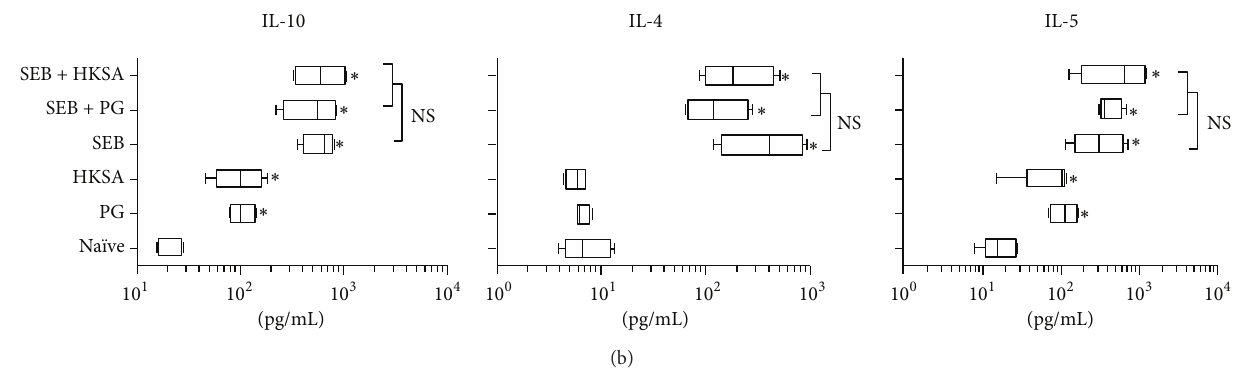
Figure 4: Effect of S. aureus -derived PAMPs on SEB-induced systemic inflammatory response syndrome in vivo . HLA-DR3 transgenic mice were challenged with staphylococcal enterotoxin B (SEB) alone (50 𝜇 g), staphylococcal peptidoglycan (PGN) alone (50 𝜇 g), or heat-killed Staphylococcus aureus (HKSA) alone (10 8 bacteria), SEB with PGN or SEB with HKSA. Animals bled 4 hours after injection and serum cytokines were quantified using Bioplex assays (Bio-Rad). Mean ± SE from 4–6 mice in each group. ∗ 𝑃 < 0.05 compared to na¨ıve mice.